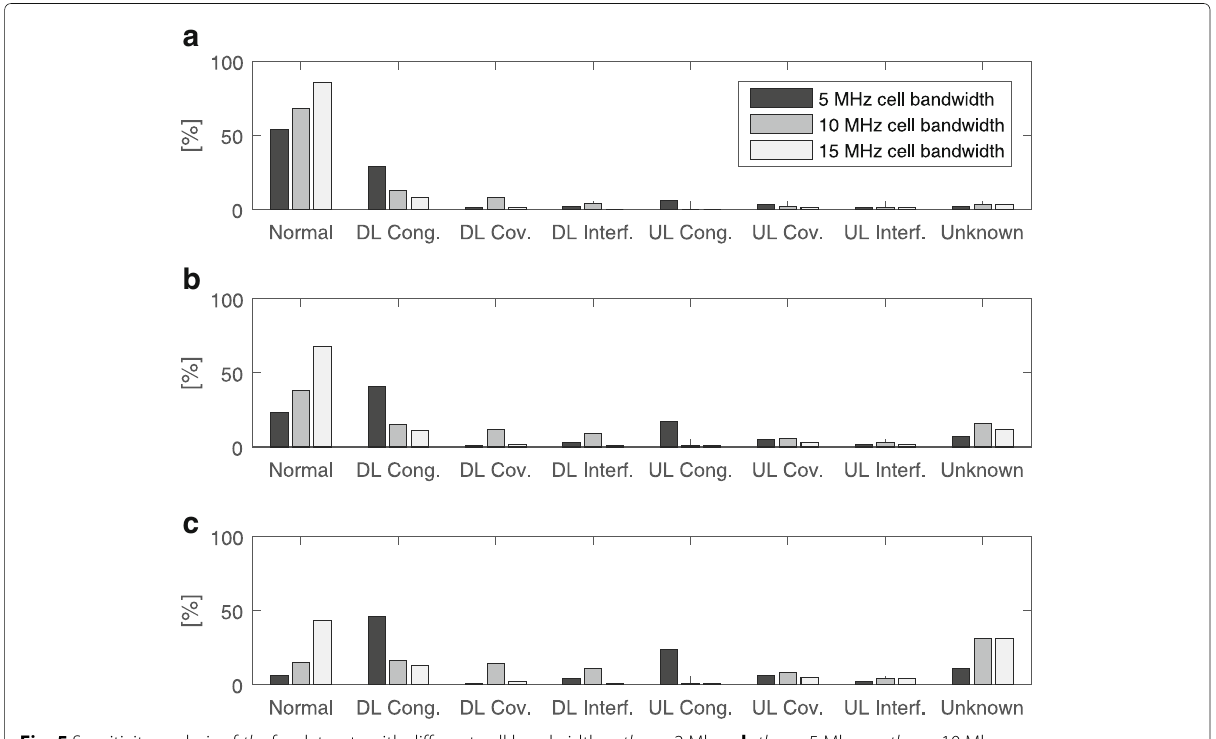
Fig. 5 Sensitivity analysis of th 1 for datasets with different cell bandwidth. a th 1 = 2 Mbps. b th 1 = 5 Mbps. c th 1 = 10